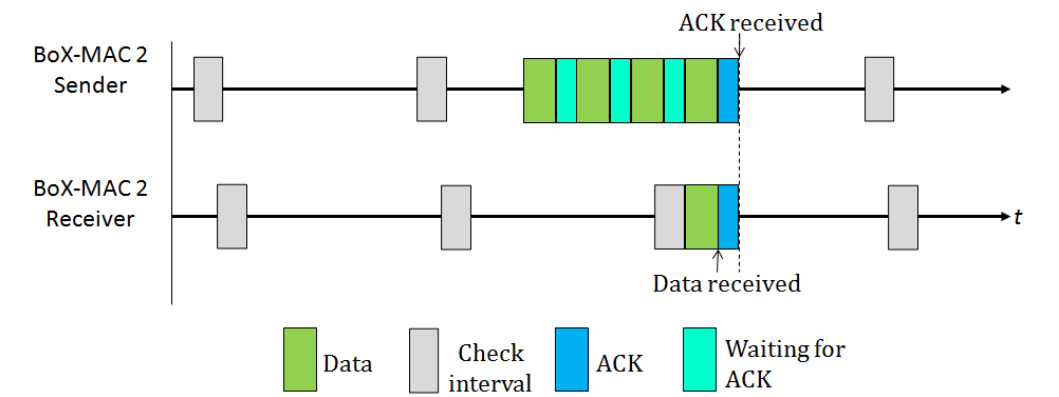
Figure 2. BoX-MAC-2 Tx/Rx